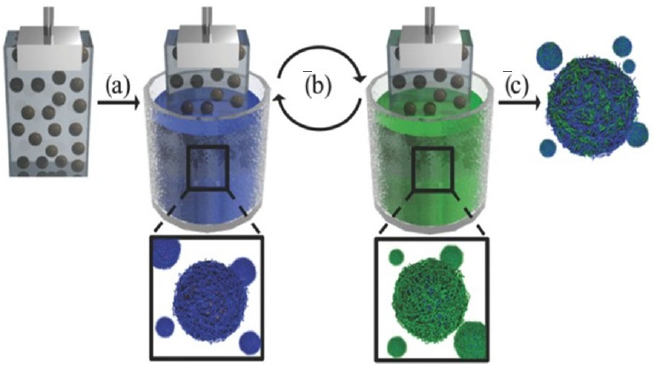
Figure 3. Sketch of the fabrication of PEMUCs using immobilized colloids as templates. The different letters indicate the different steps of the process. ( a ) Immersion of the immobilized colloid into the first layering solution and subsequent rinsing (the rinsing step is not shown for simplicity). ( b ) Immersion on the second layering solution and subsequent rinsing. ( c ) The coated colloids are recovered from the agarose matrix. The steps ( a , b ) are repeated until the desired number of layers is obtained. Reprinted from Richardson et al. [74], Copyright (2013), with permission from John Wiley and Sons.